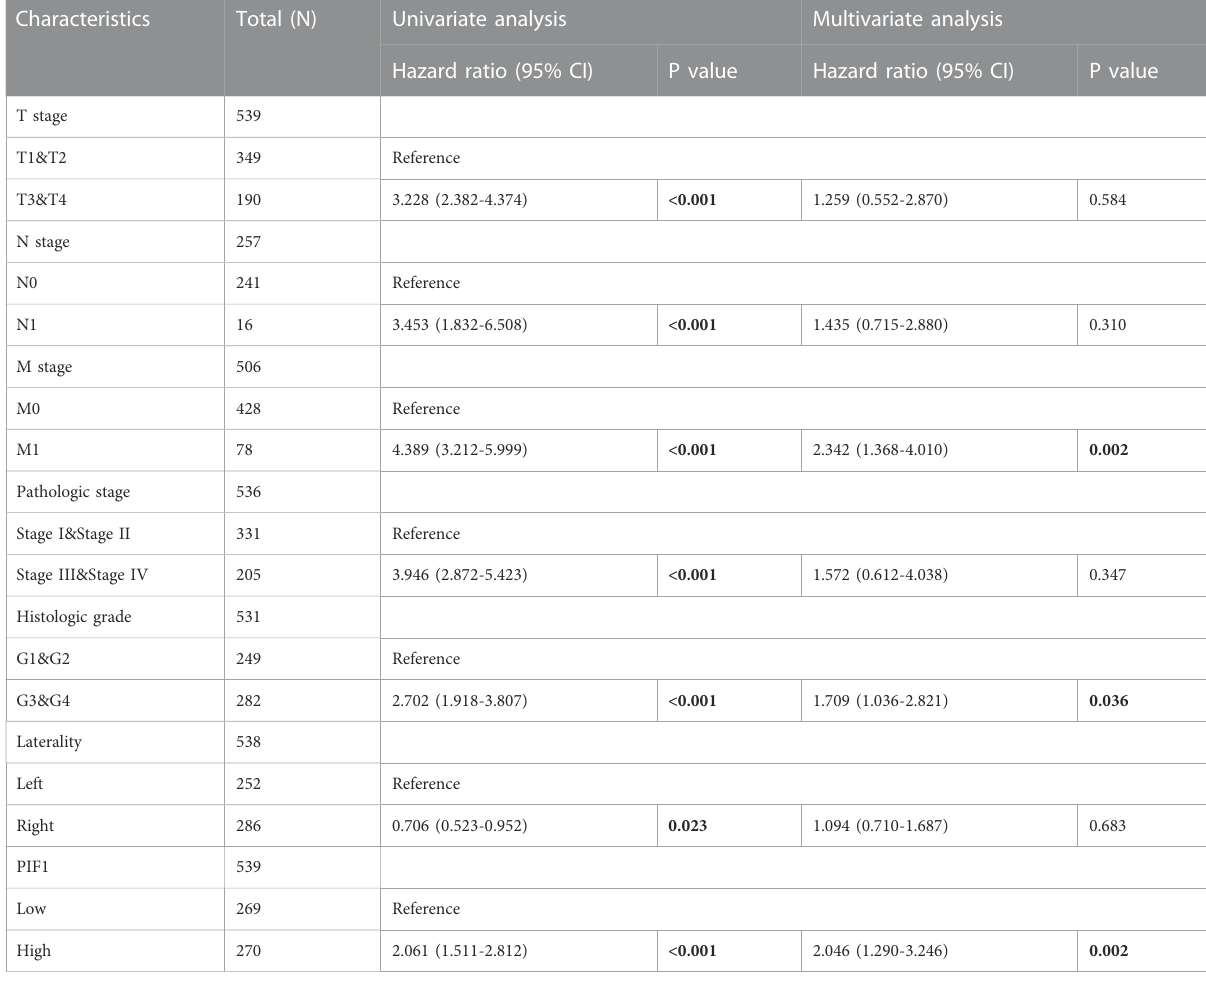
TABLE 2 Univariate and multivariate Cox proportional hazards analyses of PIF1 expression and OS for patients with ccRCC.